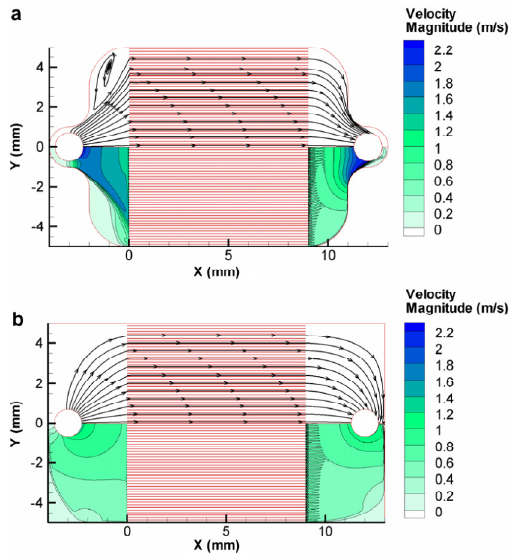
Figure 17. Velocity contours of circular top down inlets. ( a ) Constrained design around the inlet/outlet; ( b ) Unconstrained design. Reproduced from [60].